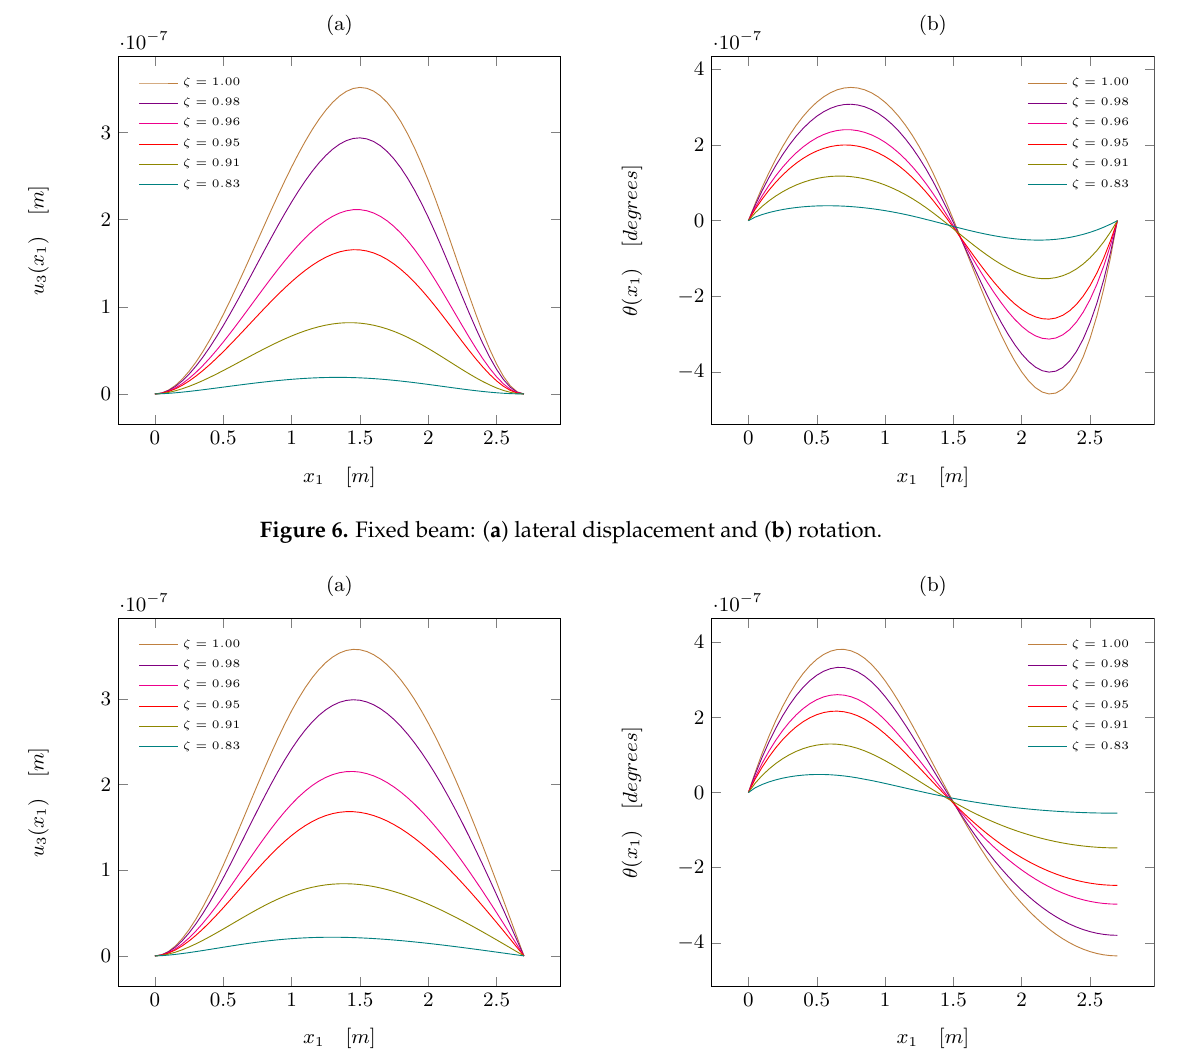
Figure 7. Propped cantilever: ( a ) lateral displacement and ( b )